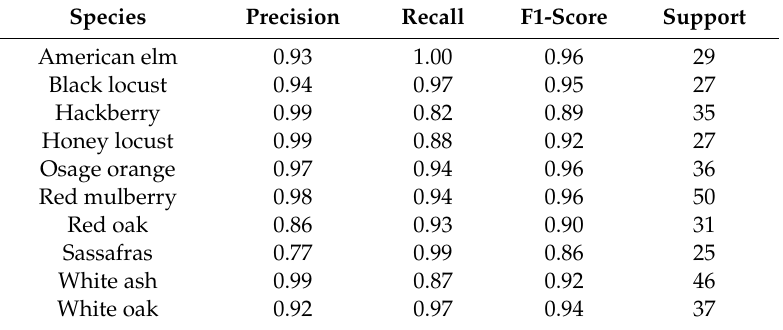
Table 1. Averaged model evaluation metrics per species.